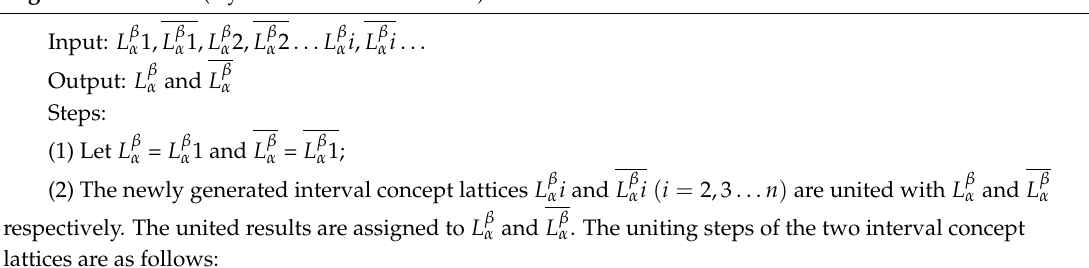
Algorithm 2. DHM (Dynamic Horizontal